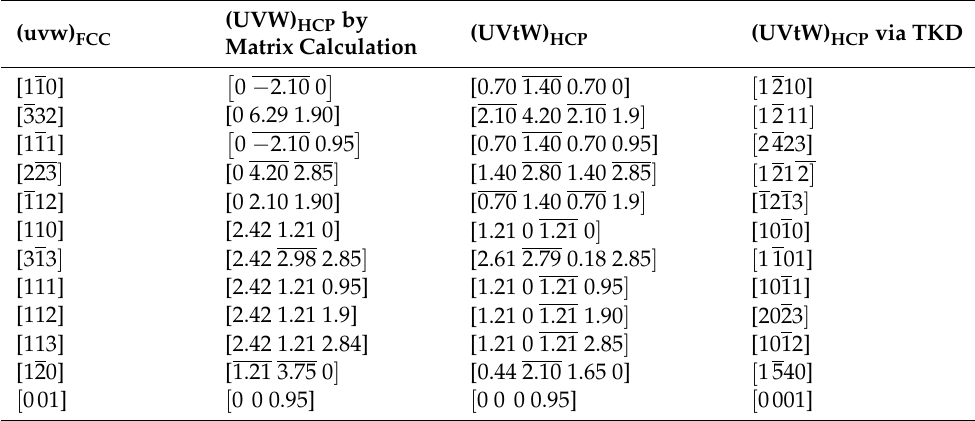
Table 3. Parallel crystal plane indexes predicted by transformation matrix and